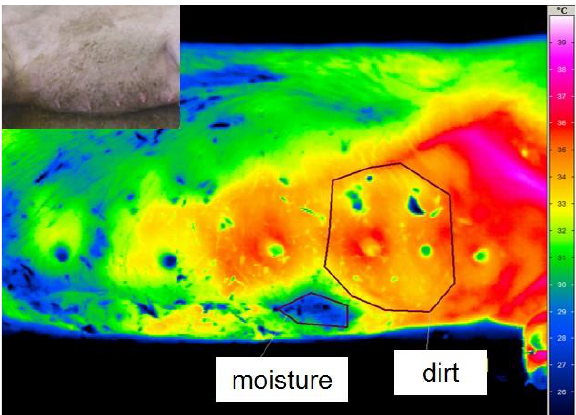
Figure 1. Colour-coded thermal image of the uncleaned udder of a lying sow: marked areas show wet (blue) and soiled (yellow, green and blue spots) areas. The temperature scale is shown on the right side of the figure. The picture at the top left shows the same image of the animal in visible light for better orientation.